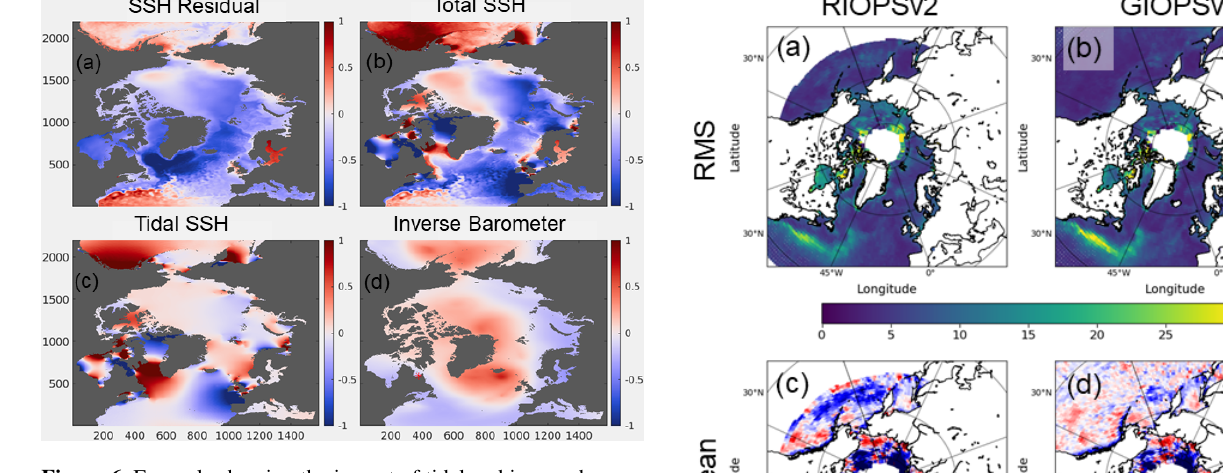
Figure 6. Example showing the impact of tidal and inverse barom- eter terms on the SLA observation operator for 31 December 2015. The SSH residual used in the SLA observation operator is shown in panel (a) . Panel (b) shows the instantaneous model SSH field prior to any treatment. The tidal component calculated using the online harmonic analysis is shown in panel (c) . Panel (d) shows the inverse barometer component. Units are meters (m). Fields are plotted on the native model grid with grid point numbers shown on the x and y axes. The SST residual (a) is calculated as the total SSH field (b) minus the tidal SSH (c) and the inverse barometer term (d) .